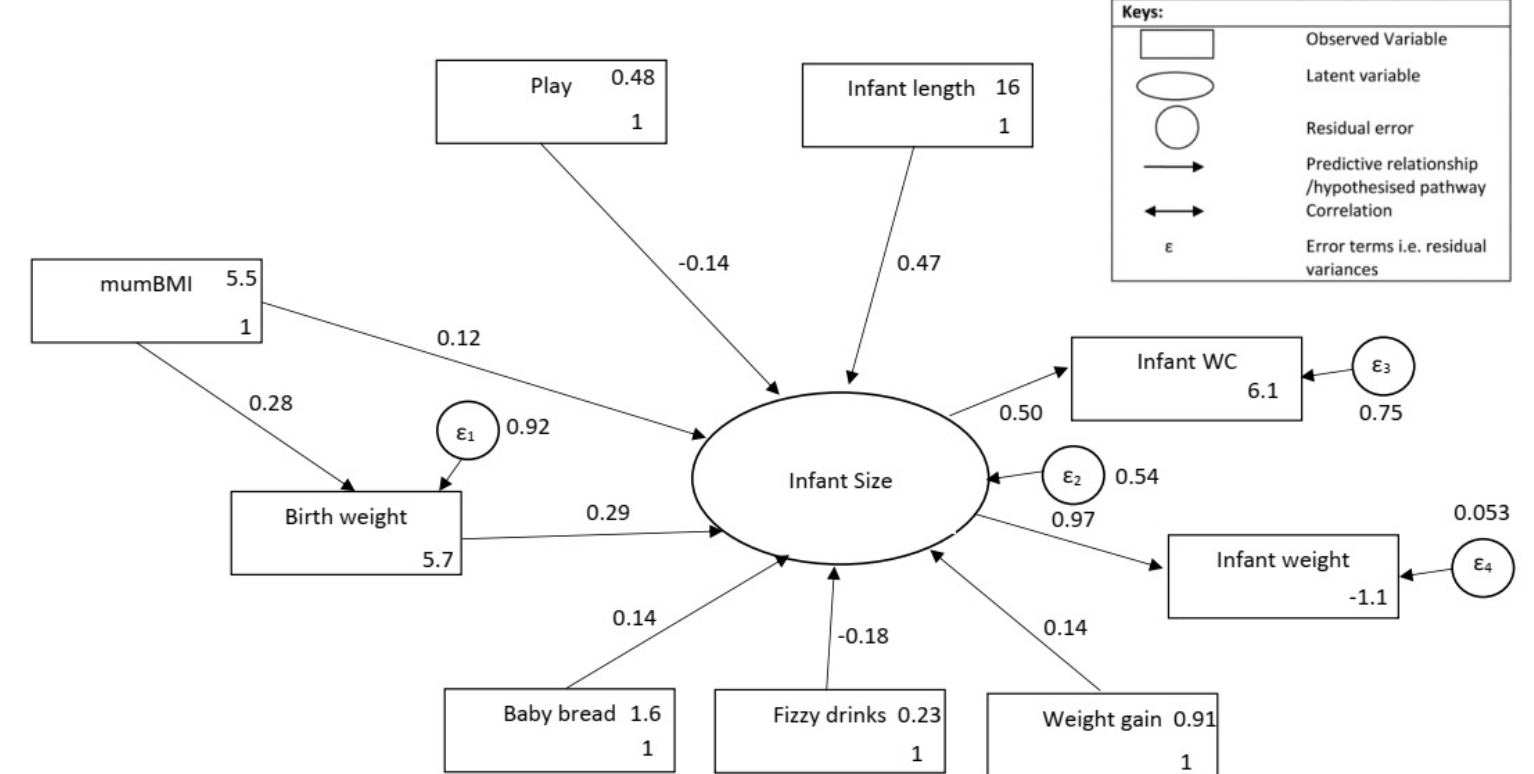
Figure 2. Modified structural equation model displaying standardised coefficients ( χ 2 (11) = 21.5, p < 0.05; RMSEA = 0.07; CFI = 0.94; SRMR = 0.05). mumBMI (mother’s BMI at 12 weeks gestation), play (infant plays with parent or physically active games daily or less often), infantlength (length at age 12 months), babybread (infant consumes carbohydrates daily or less often), fizzydrinks (infant consumes carbonated drinks daily or less often), weightgain (infant average weekly weight gain (g) from birth to 6 months), infantsize (factor of infant waist circumference (infant wc) and infant weight, both measured at age 12 months).